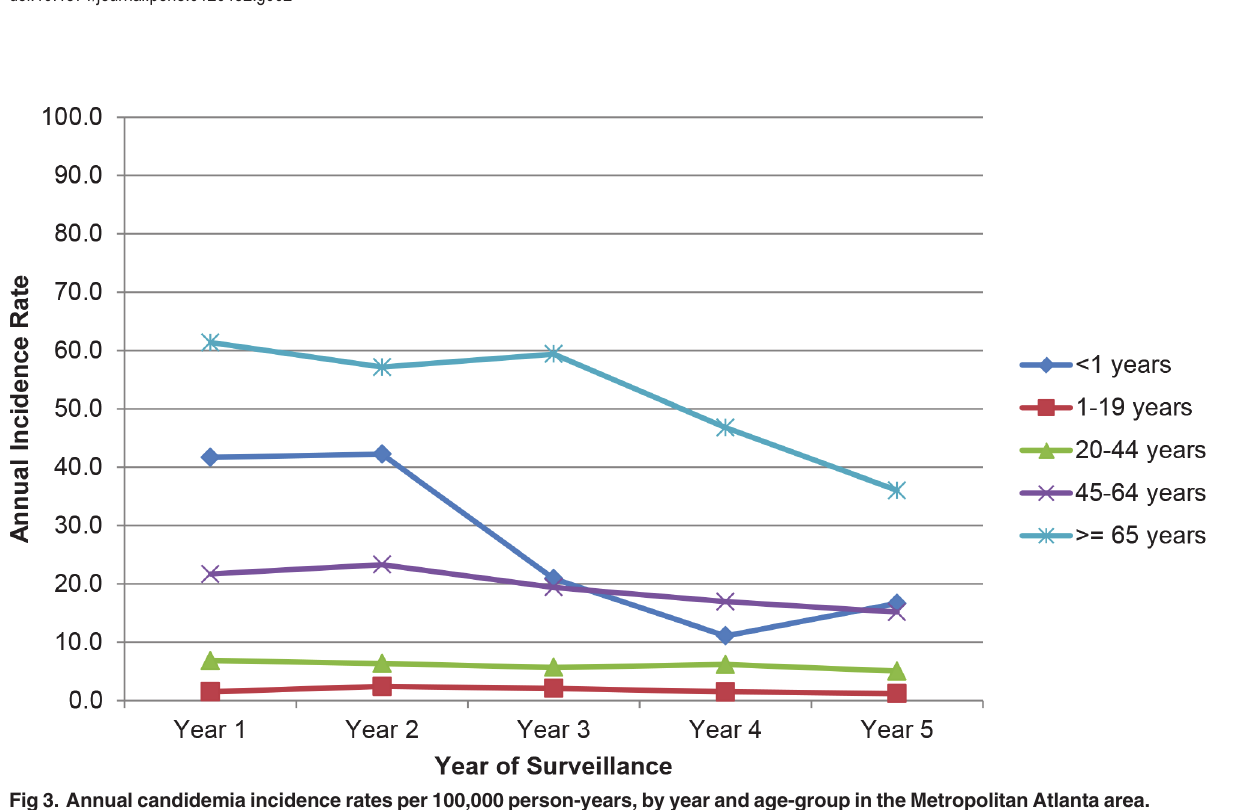
PLOS ONE | DOI:10.1371/journal.pone.0120452 March 30, 2015 6 /